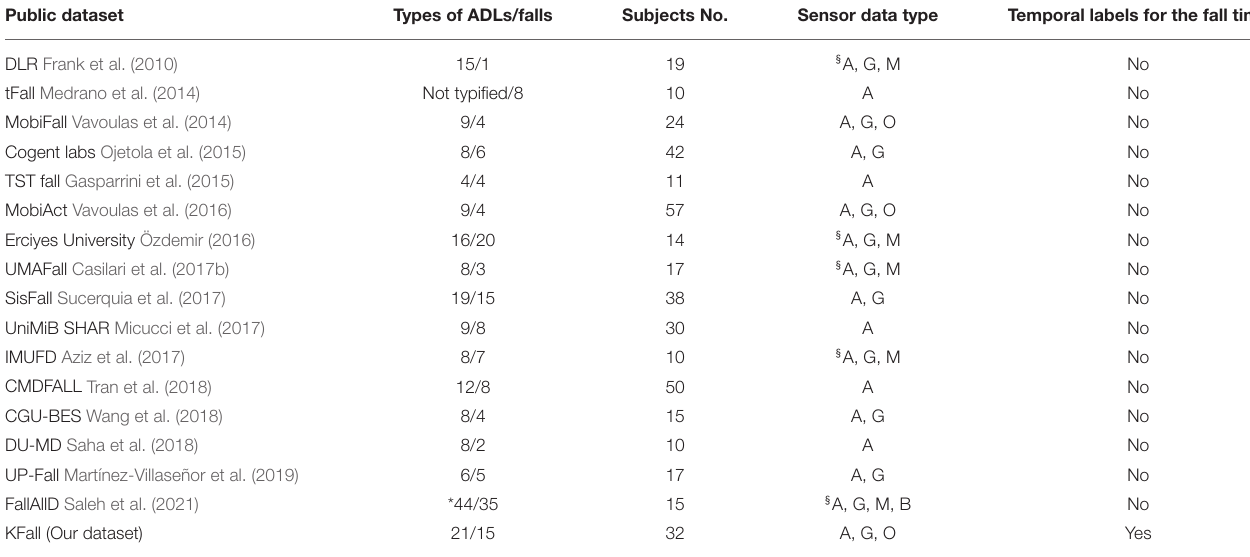
TABLE 1 | Wearable inertial sensor-based public datasets for fall detection. Public